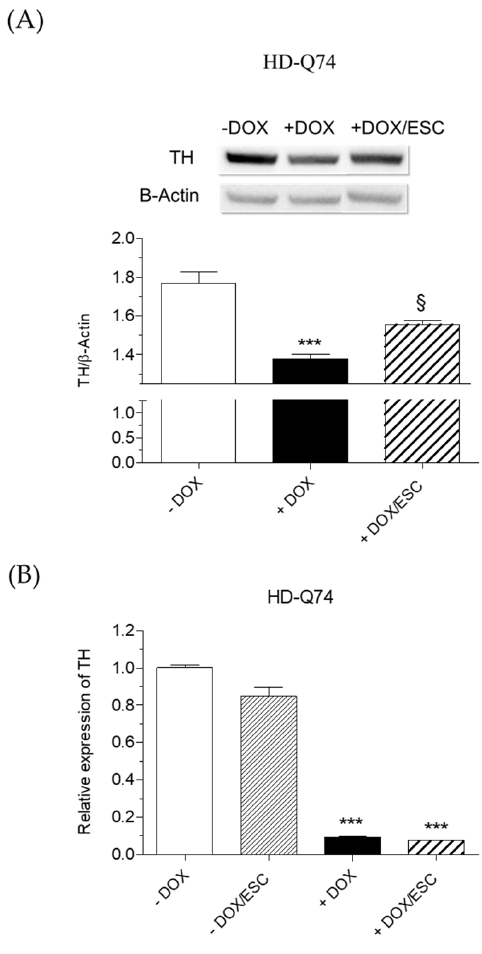
Figure 5. Effects of ESC on TH levels upon induction of mHTT in HD-Q74 cells. HD-Q74 cells were incubated with DOX (1 µ g/mL) for 3 days and ESC (5 µ M) was added during the last 24 h of incubation with DOX. TH protein levels ( A ) and gene expression ( B ) were evaluated by western blotting and RT–PCR, respectively, as described in the Materials and Methods. Data are expressed as TH protein levels and relative normalized gene expression and are reported as the mean ± SEM of at least three independent experiments (*** p < 0.001 vs. HD-Q74 ( − DOX) and § p < 0.05 vs. HD-Q74 (+DOX) at one-way ANOVA with Bonferroni post hoc